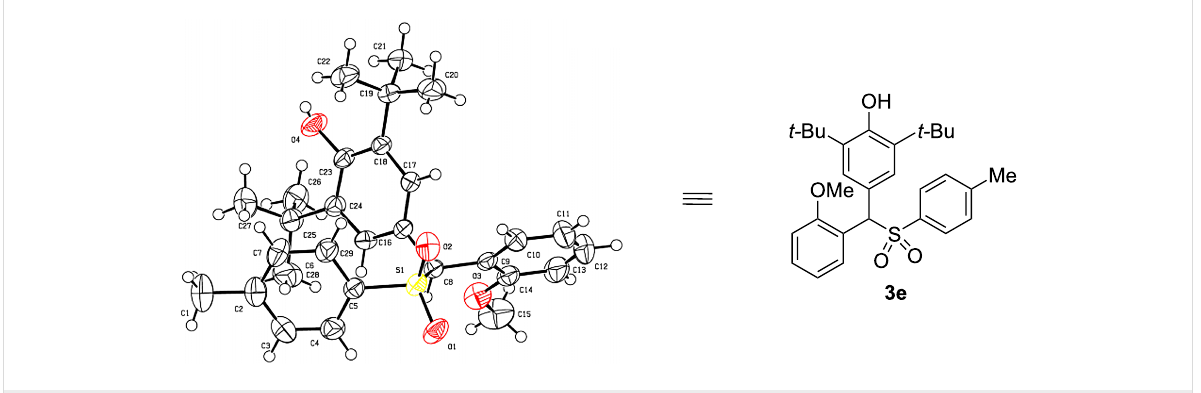
Figure 2: Crystal structure of diarylmethyl sulfone 3e